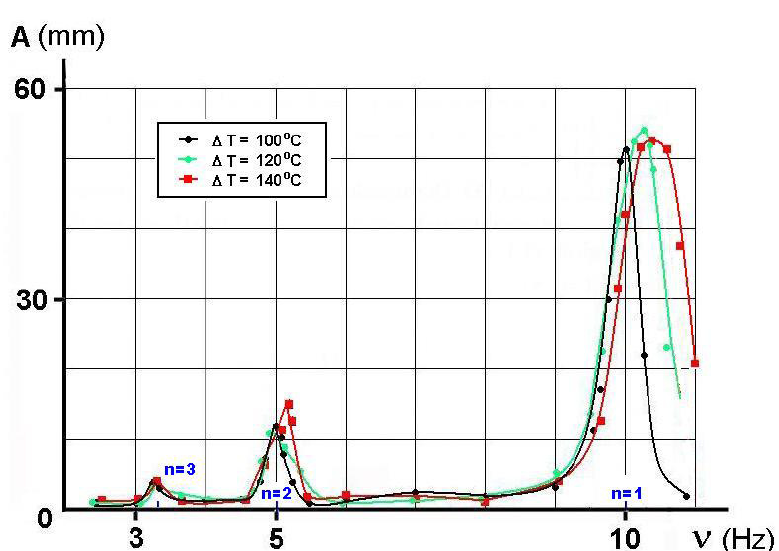
Figure 2. Resonance spectra displaying the amplitude of the oscillating thin heater, A, as a function of the frequency of external modulation, ν , at various temperature differences ∆ T = T − T 0 ( T denotes the time averaged temperature of the wire during a stationary oscillation and T 0 the temperature of the surrounding air). The lines are a guide to the